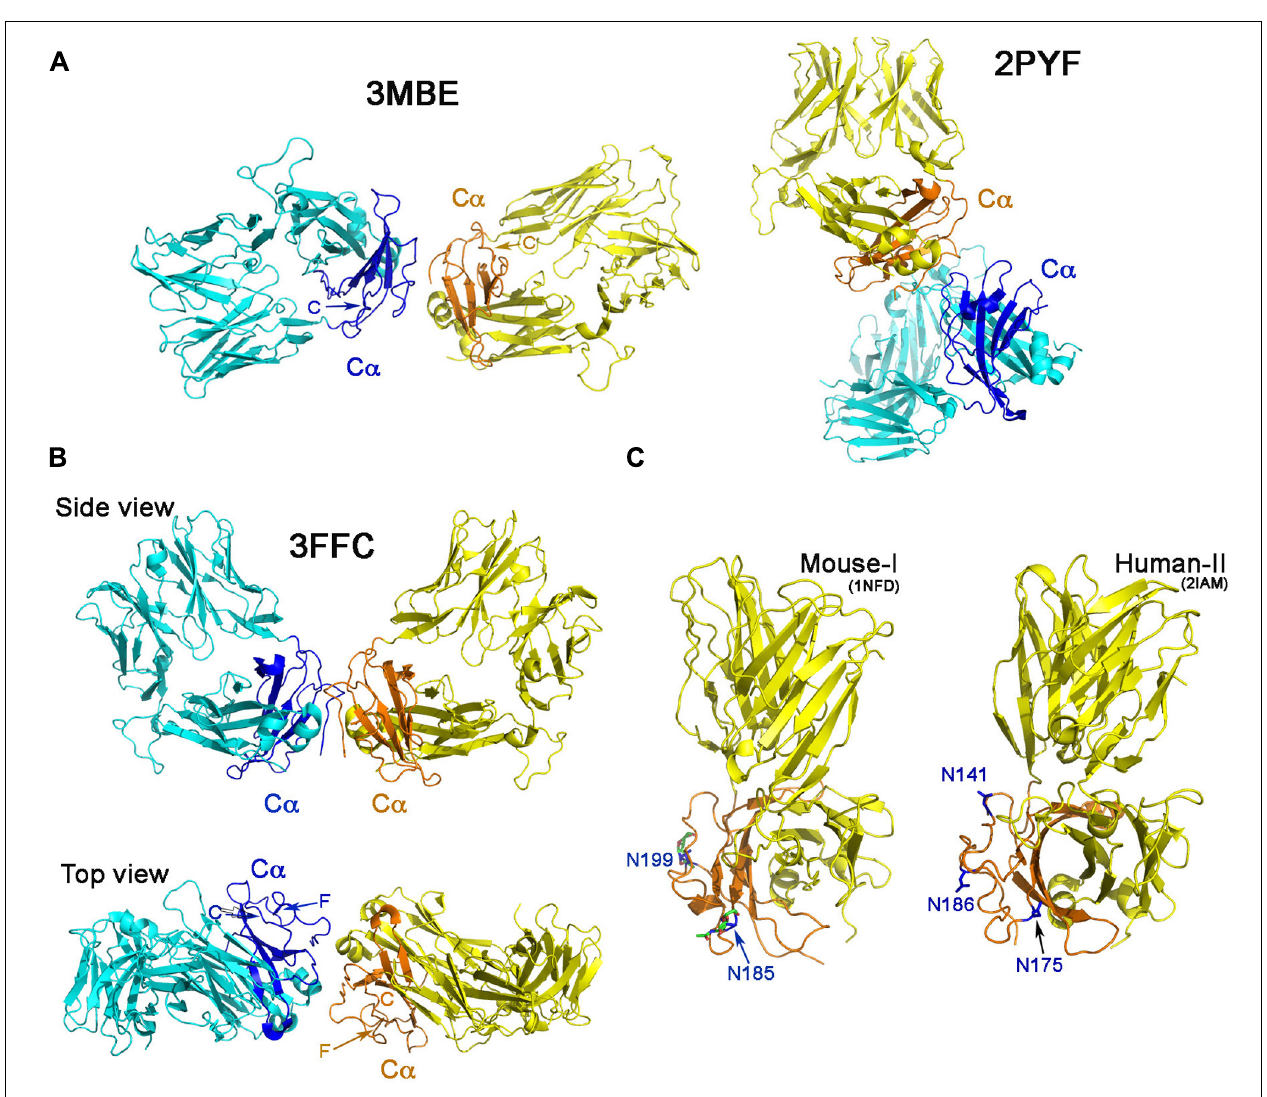
FIGURE 2 | “Dimers” involving the C α domain in αβ TCR/pMHC complexes. (A) The dimeric model in two crystal structures.The structure of 2PYF in the right panel is not a symmetric dimer, whereas the structure of 3MBE in the left panel reveals a dimer apparently lying flat on the cell membrane, so of questionable biological significance. In panels (A) and (B) the C α domains are shown in dark blue and orange. (B) Two views of